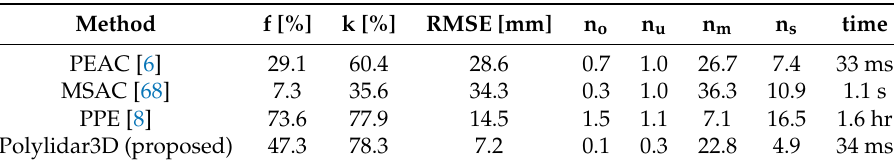
Table 10. SynPEB Benchmark